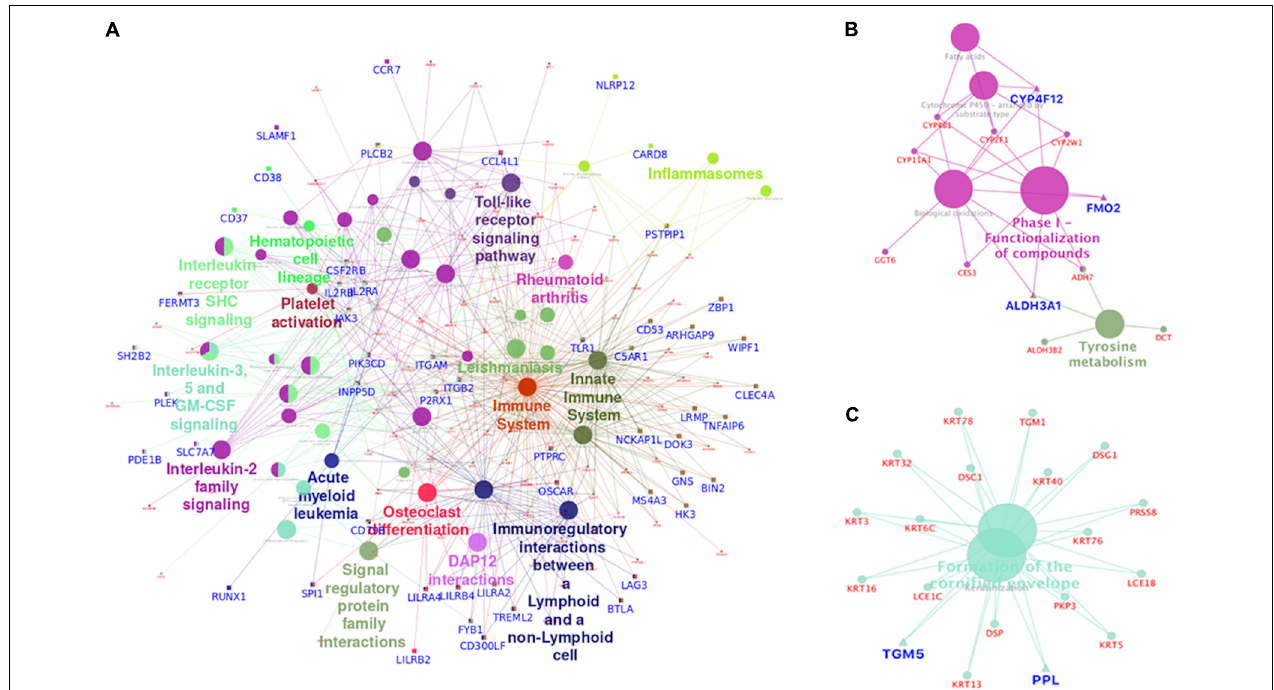
FIGURE 6 | Functionally grouped network visualization for epigenetically upregulated and downregulated genes. Each Node represents a pathway and the node size represents the particular term’s enrichment significance ( P -value). Genes highlighted in blue are of epigenetically significant genes. Epigenetically upregulated genes were found to be over-represented in immune system pathways and osteoclast differentiation pathways indicating immune evasion and bone marrow invasion (A) potential of tumor derived oropharyngeal cancer cells. Enrichment of epigenetically silenced genes in the xenobiotic metabolism (B) pathway suggests reduced carcinogen tolerance in oropharyngeal cancer cells. Also epigenetic down regulation of keratinization (C) pathway related genes indicate escape from growth inhibition by cell to cell